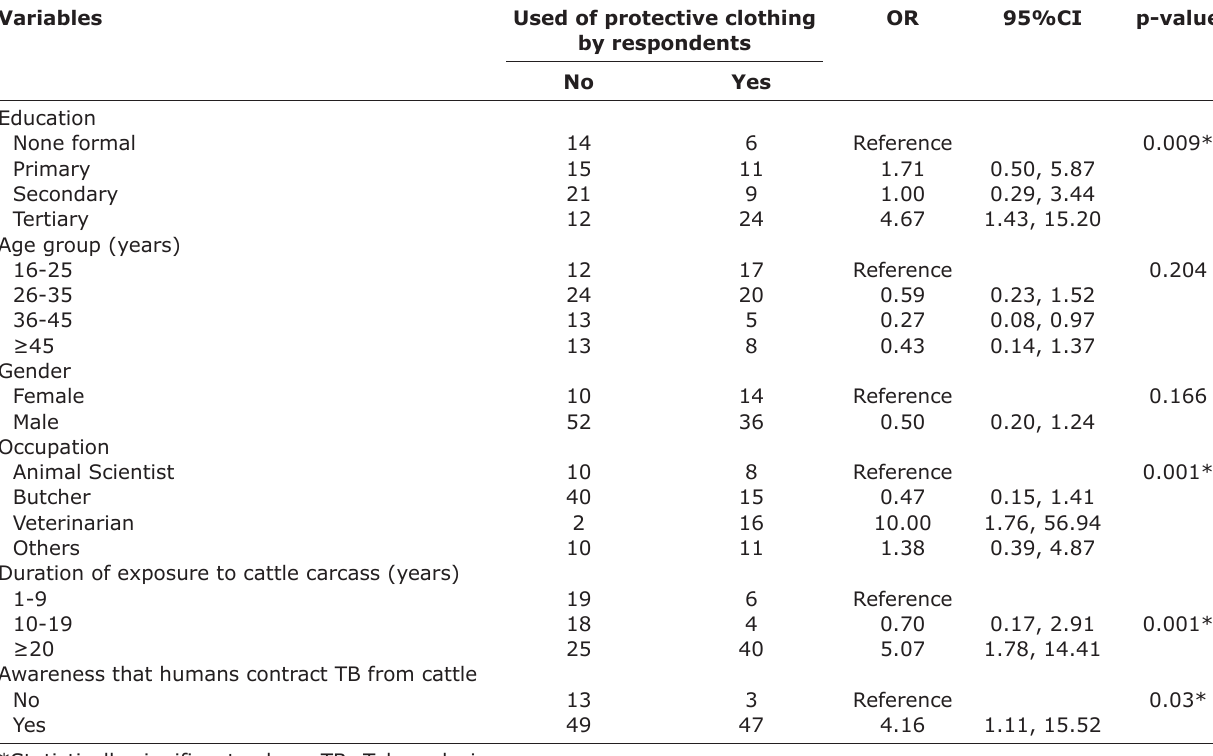
Table-2: Risk analysis of some variables and other practices during work (use of protective clothing) among abattoir personnel (n=112) in Gombe State. Variables Used of protective clothing by